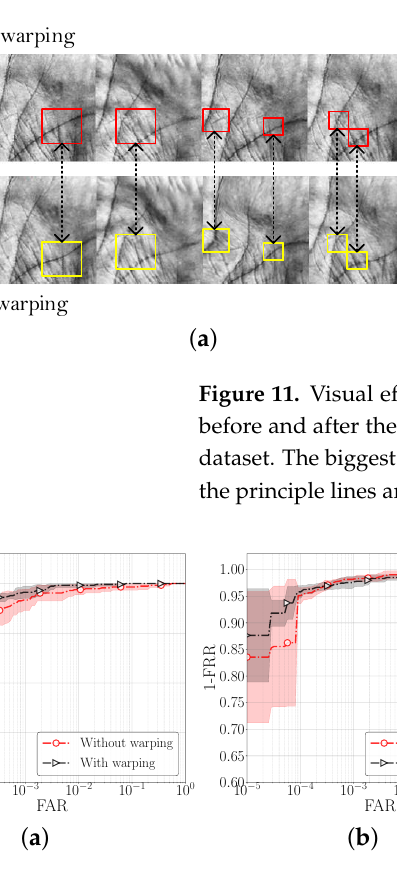
Figure 12. Impact of using TPS warping as an augmentation technique on the verification per- formance. The results are shown in the form of mean ROC curves with confidence intervals when the models are trained on: ( a ) IITD left, ( b ) IITD right, ( c ) CASIA left and ( d ) CASIA right palmprints, respectively.